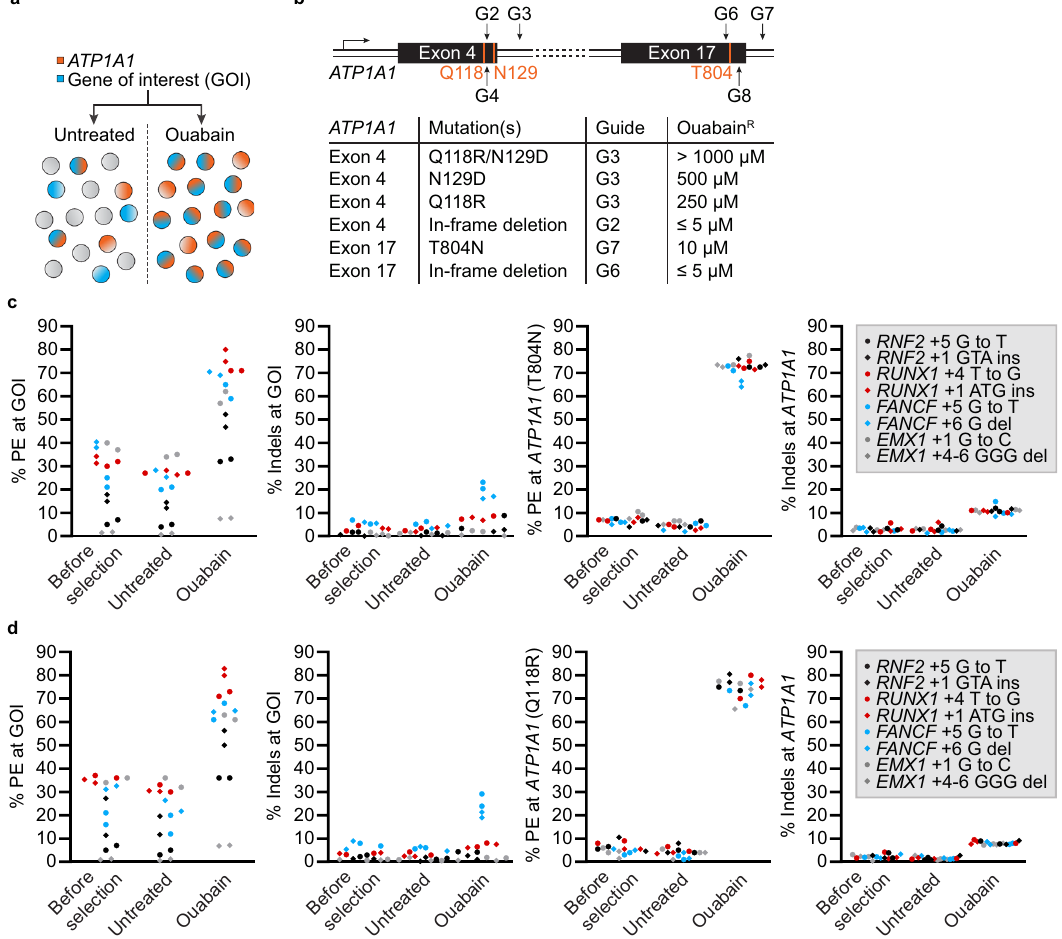
Fig. 1 | Robustco-selectionfor primeediting. a Schematic for theco-enrichment ofCRISPR-driveneditingeventsataGOI. b Schematicrepresentationofthe ATP1A1 locus regions targeted by SpCas9. The fi rst and third extracellular loops of the Na + /K + ATPase are encoded by ATP1A1 exon 4 and 17, respectively. The relative levels of resistance to ouabain conferred by different ATP1A1 mutations in K562 cells are shown. c PE and small indels quanti fi cation as determined by BEAT and TIDE ana- lysis from Sanger sequencing. K562 cells were transfected with PE3 vectors